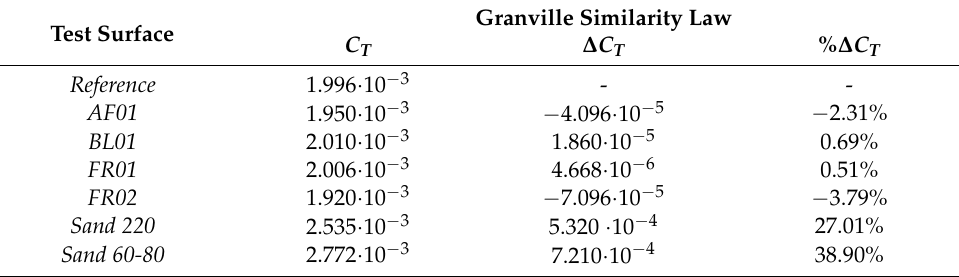
Table 9. Total resistance coefficients of the full-scale KCS at 24 knots ( Fn = 0.26